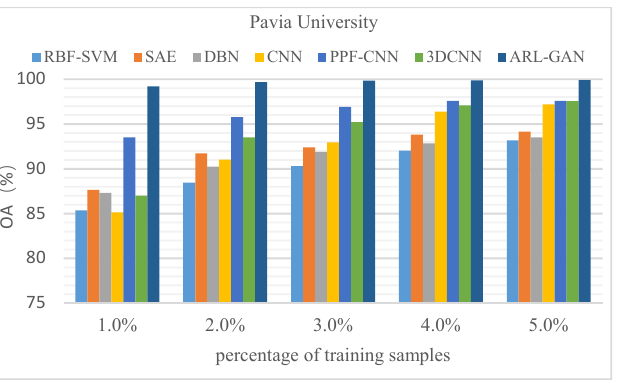
Figure 8. Accuracy of seven classification algorithms for the PaviaU dataset under different numbers of training samples.